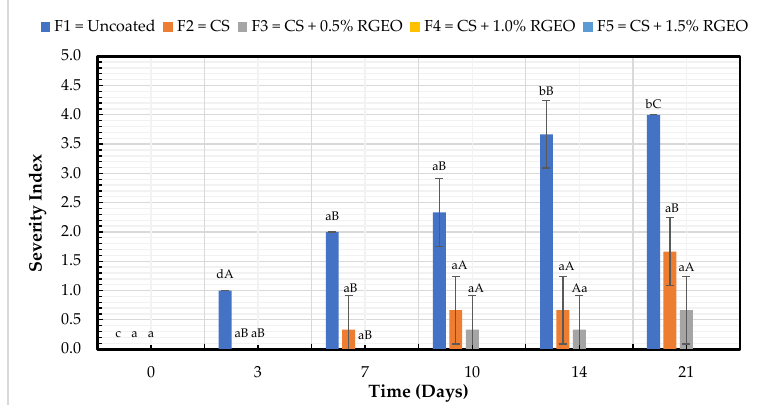
Figure 8. Evolution of the decay index in pears with chitosan (CS) and treatments of oil (RGEO): F1 = control, F2 = CS, F3 = CS + RGEO 0.5%, F4 = CS + RGEO 1.0%, and F5 = CS + RGEO 1.5%. According to the ANOVA test, mean values and intervals of Duncan test for treatments and Fisher for days with 95%. Different lowercase letters (a, b, c) indicate significant differences between days according to the LSD Fisher test for each treatment in a confidence interval of 95%. In contrast, different uppercase letters (A, B, C) indicate significant differences between treatments for each day according to the Duncan test in a confidence interval of